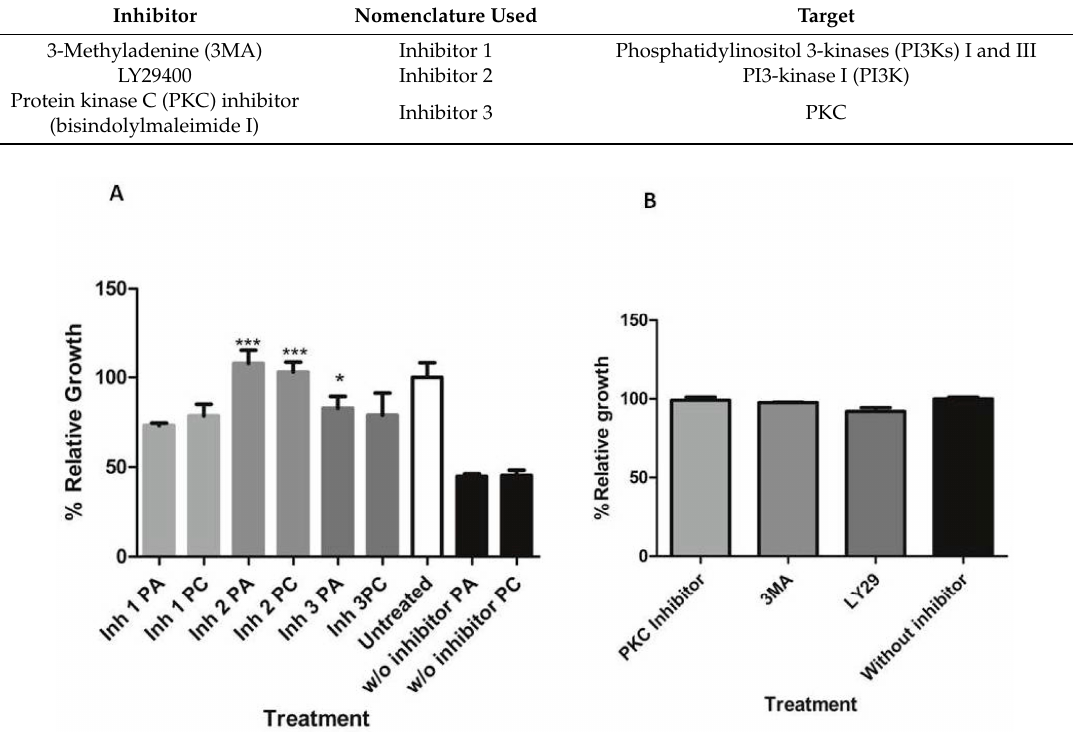
Figure 10. Erythrocytes infected with P. falciparum were either incubated without (w/o inhibitor) or pre-incubated with inositol triphosphate 3-kinase (IP3K; 5 μ M) and protein kinase C (PKC; 4 μ g/mL) inhibitors and then treated with pumilacidins A and C at 10 μ M ( A ) or not ( B ). The growth of the parasites was analyzed by flow cytometric detection of DNA 24 h afterward, and compared to the untreated culture controls incubated with each respective inhibitor. The bars represent the mean of three individual experiments in duplicate ( A ) or the mean of two individual experiments in duplicate ( B ). * p < 0.05; *** p < 0.001.